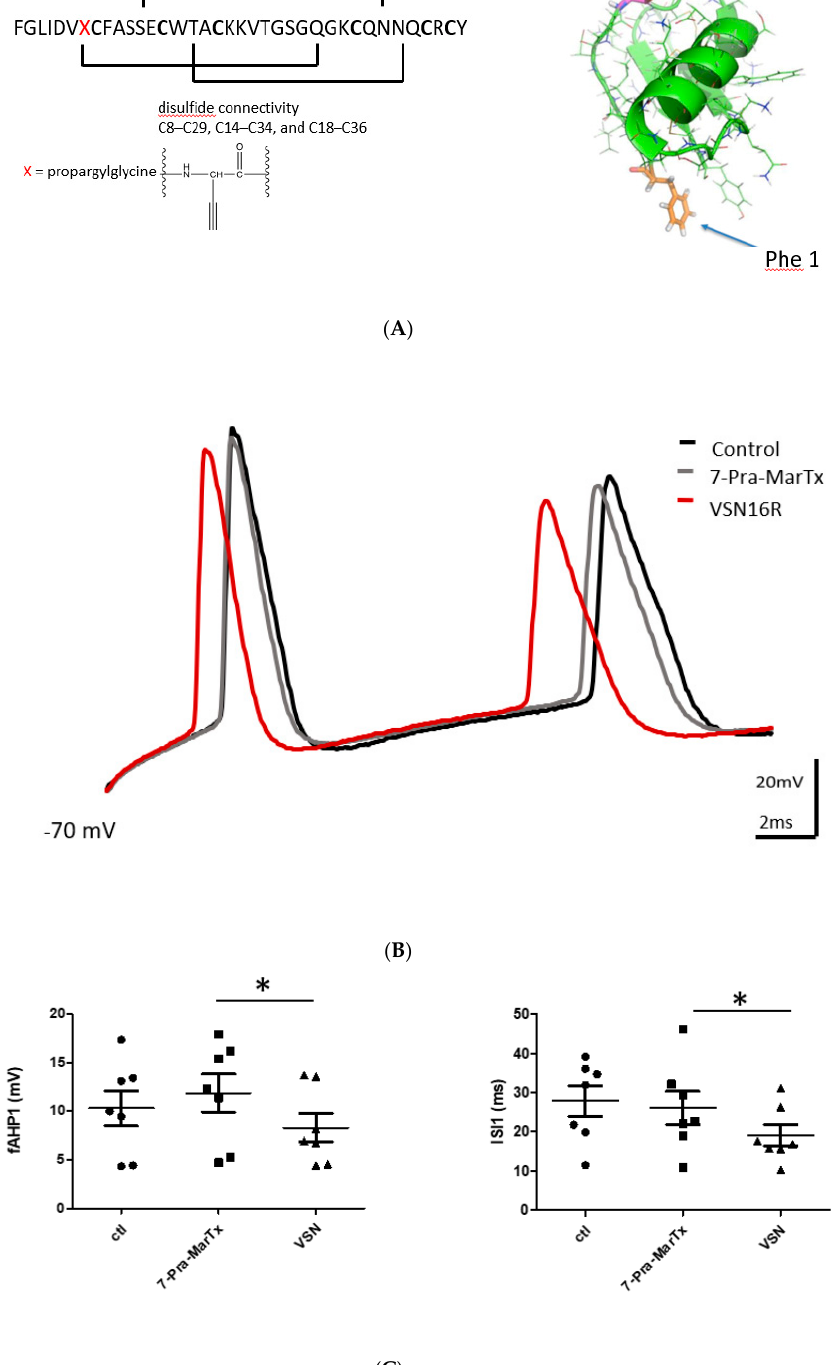
Figure 3. E ff ects of 7-Pra-MarTx and VSN16R on AP waveform under high and low frequency stimulus. ( A ) Amino acid sequence, connectivity and ribbon diagram showing 3D structure of 7-Pra-MarTx. ( B ) Exemplar trace showing e ff ects of 7-Pra-MarTx and subsequent application of 100 µ M VSN16R under high frequency stimulus. ( C ) E ff ects before (control) and at steady state after application of 100 nM 7-Pra-MarTx and 100 µ M VSN16R on absolute change of first fAHP amplitude from resting potential and first ISI under low frequency stimulus. Data from n = 7 cells; * = P < 0.05.